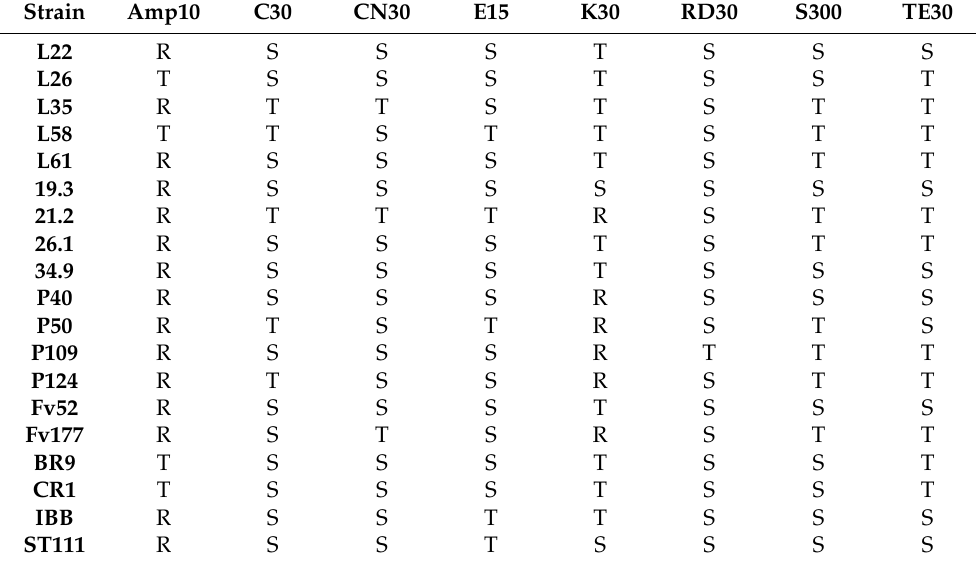
Table 6. Antibiotic susceptibility of the studied LAB strains.